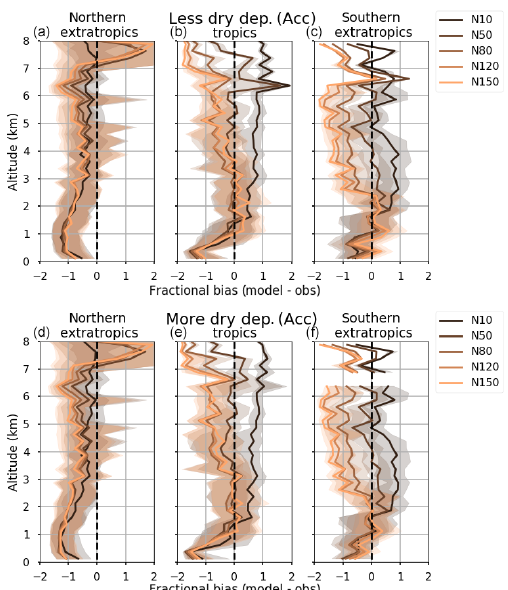
Figure C2. The vertical profile of fractional bias in modelled aerosol number at different size cut-offs for measurements in the northern extratropics (a) , the tropics (b) and the southern extratropics (c) with reduced (by a factor of 0.1) and increased (by a factor of 10) dry deposition in the accumulation